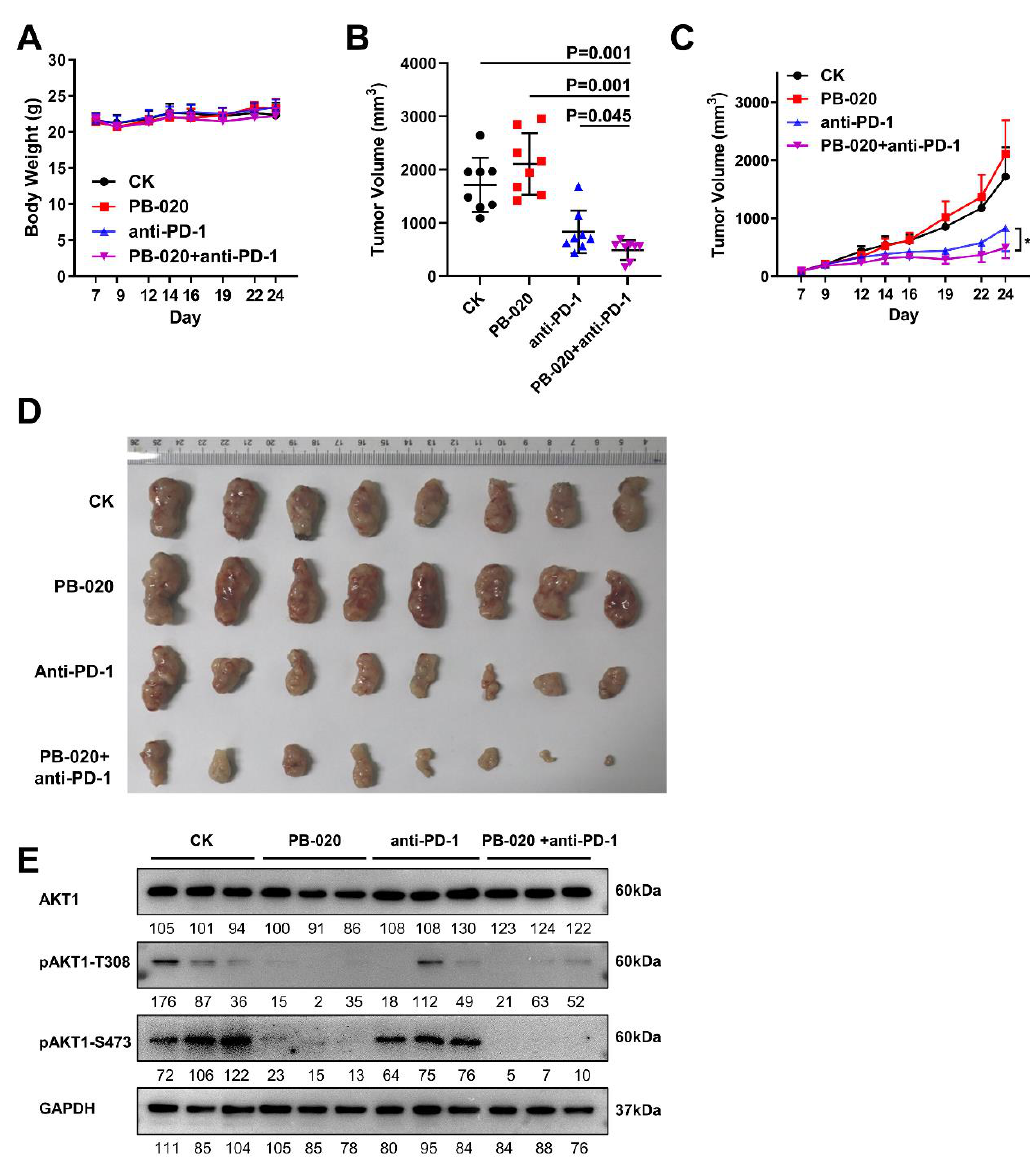
Figure 4. PB-020 in combination with PD-1 blockade inhibited propagation of MC38 colorectal cancer in vivo. ( A ) MC38 cells were subcutaneously implanted in C57BL/6 mice in a syngeneic mouse CRC model. The mice were administered with a vehicle (CK), PB-020, anti-PD-1 monoclonal anti- body RMP1-14 or PB-020/anti-PD- 1 combination, as detailed in “Materials and methods”. The effect of compound administration on body weight changes in xenograft mice is presented. ( B ) Tumor volumes at day 24 were plotted. The statistical significance of data was evaluated using the two- tailed unpaired Student’s test. ( C ) Tumor volumes as a function of time (days) were plotted. The statistical significance of data was evaluated using the two- tailed unpaired Student’s test, and dif- ferences were considered significant at * p < 0.05. ( D ) At the end of the experiments, the excised tumors were photographed and presented. ( E ) pAKT1 inhibitory effects of PB-020, anti-PD-1 and combined PB-020 + anti-PD-1 in MC38 tumor tissues were assessed by WB. 3.5. PB-020 in Combination with PD-1 Blockade Suppressed Transcription of PI3K/AKT Pathway Genes